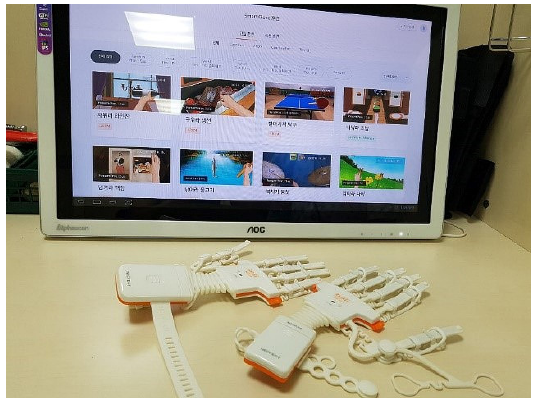
Figure A1. Wearable device (RAPAEL Smart Gloves).